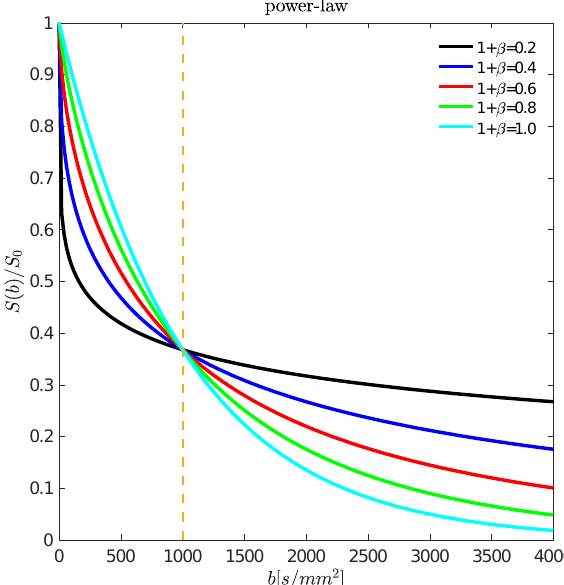
Figure 3. The normalized signal decay of S(b) / S 0 for a stretched exponential decay is plotted for b -values between 0 and 4000 s / mm 2 , and D 0 = 1 × 10 − 3 mm 2 / s. Five values for (1 + β ) = 0.2, 0.4, 0.6, 0.8, and 1.0 are displayed. The last value in this sequence gives the single exponential function. As the value of (1 + β ) moves toward 1, the shape of the decay curve transitions from a multiple exponential with fast and slow components to a single exponential decay.